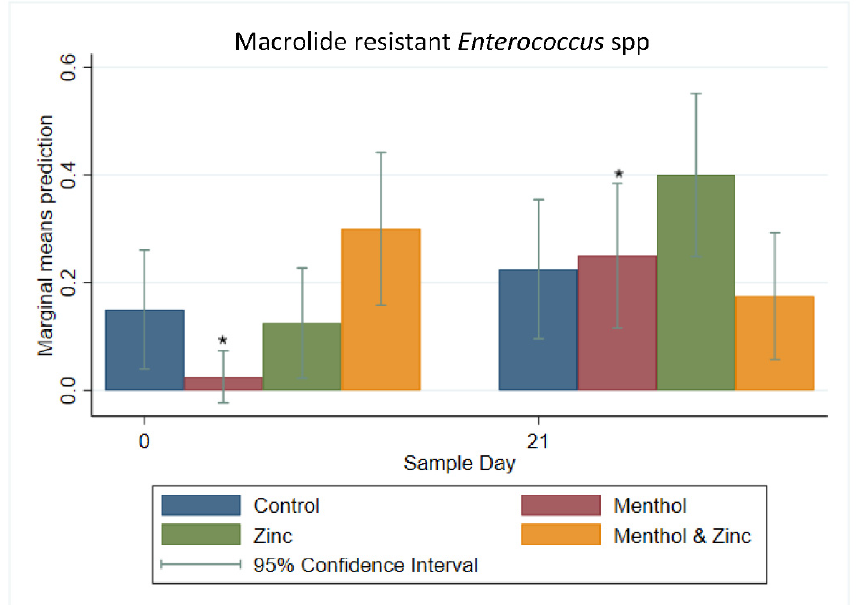
Figure 10. Marginal means with 95% confidence intervals of a 2 × 2 × 2 multi-level mixed logistic regression model, using factors of zinc, menthol and sample day on the binary outcome of macrolide resistant Enterococcus spp. * significantly different (p < 0.05) using a post hoc Bonferonni pairwise comparison.